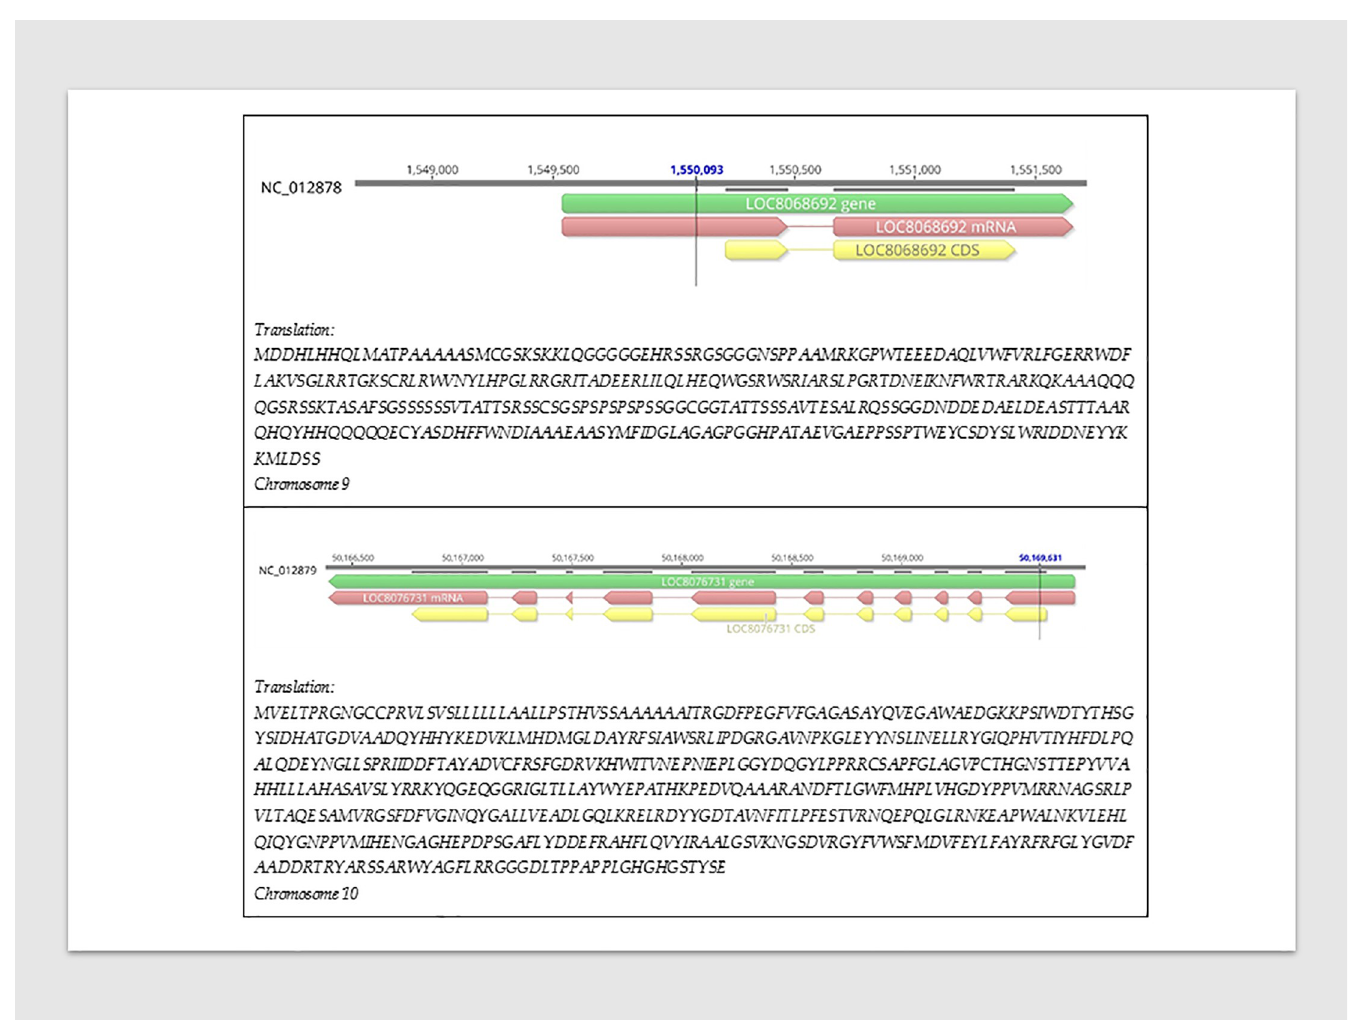
Fig 9. Functional markers, genes, coding sequence, transcripts, and the aminoacid sequences of the gene products of interest. The position (in base pairs) of the functional marker is indicated by a vertical bar. For each chromosome, from top to bottom: numbers represent the physical map (distance) in base numbers; solid line represents the region of the chromosome of interest as identified by unique NCBI identification number (ID) for the reference Sorghum bicolor NCBIv3 primary assembly; dashed horizontal lines are exons; horizontal green arrowed-bar represents the gene locus (and ID) of interest derived by automated computational analysis using Gnomon eukaryotic gene prediction algorithm; horizontal dashed red arrowed-bar represents the messenger ribonucleic acid macromolecule (along with ID) corresponding to gene of interest; the horizontal dashed yellow arrowed-bar represents the coding sequence (CDS along with ID) of the gene of interest. The direction of arrows indicates the DNA and RNA 5 0 -to-3 0 direction. The translation reports the the letters representing the sequence (in one-letter code format) of the aminoacids making up the gene product of